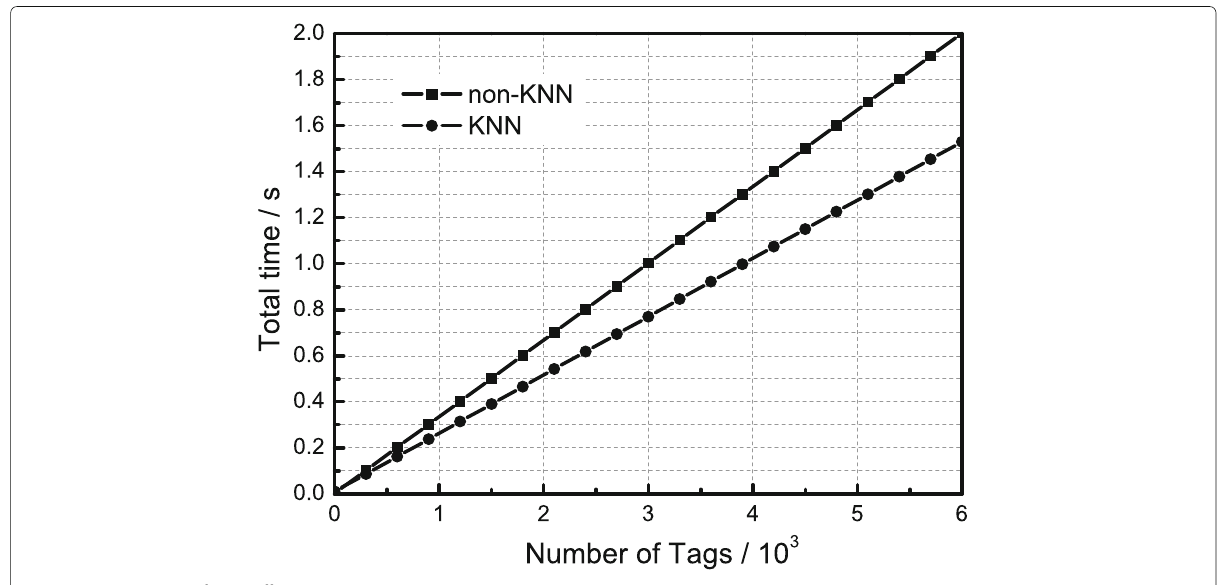
Fig. 12 Comparison of time